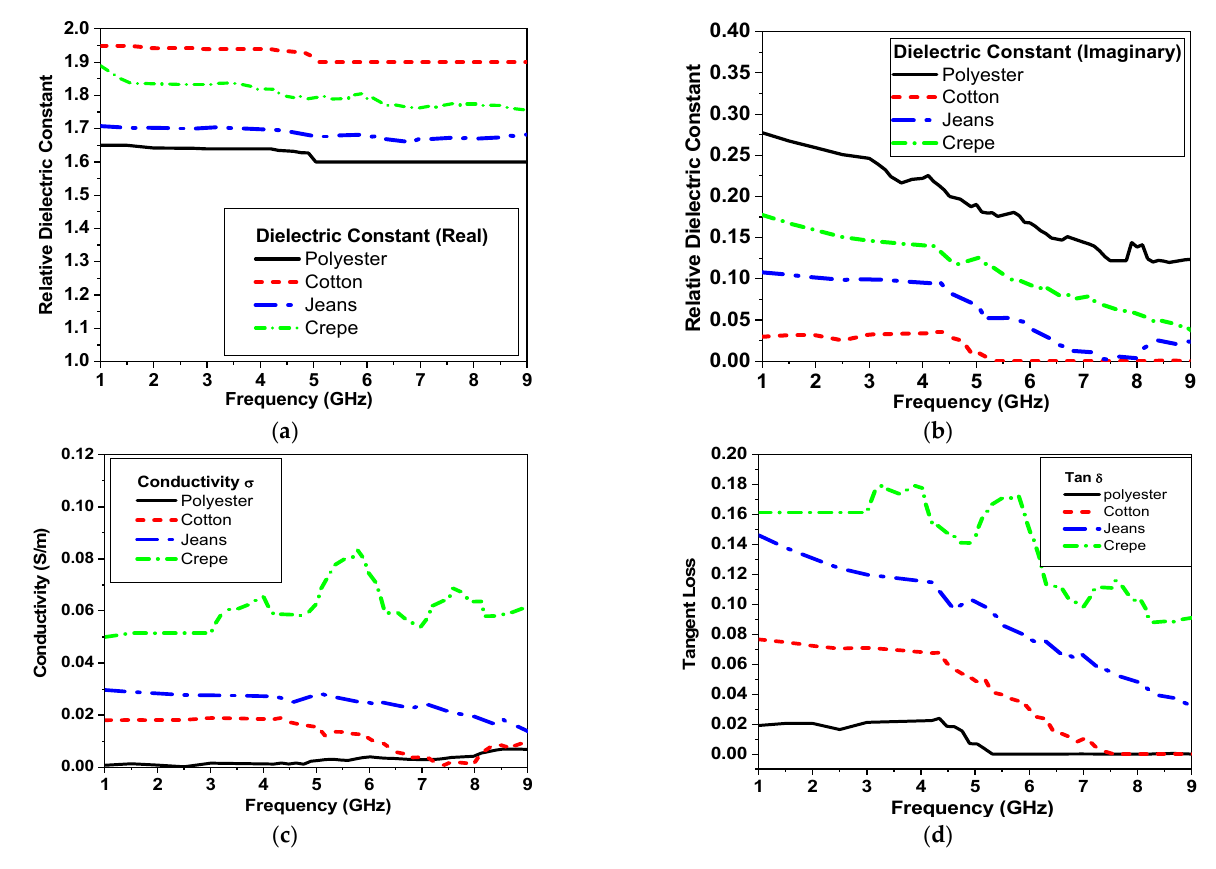
Figure 2. Measured electrical properties of different textiles versus frequency: ( a ) real part of dielectric constant ( ε′ ), ( b ) imaginary part of dielectric constant ( ε″ ), ( c ) Conductivity ( σ ) and ( d ) loss tangent (tan δ ).